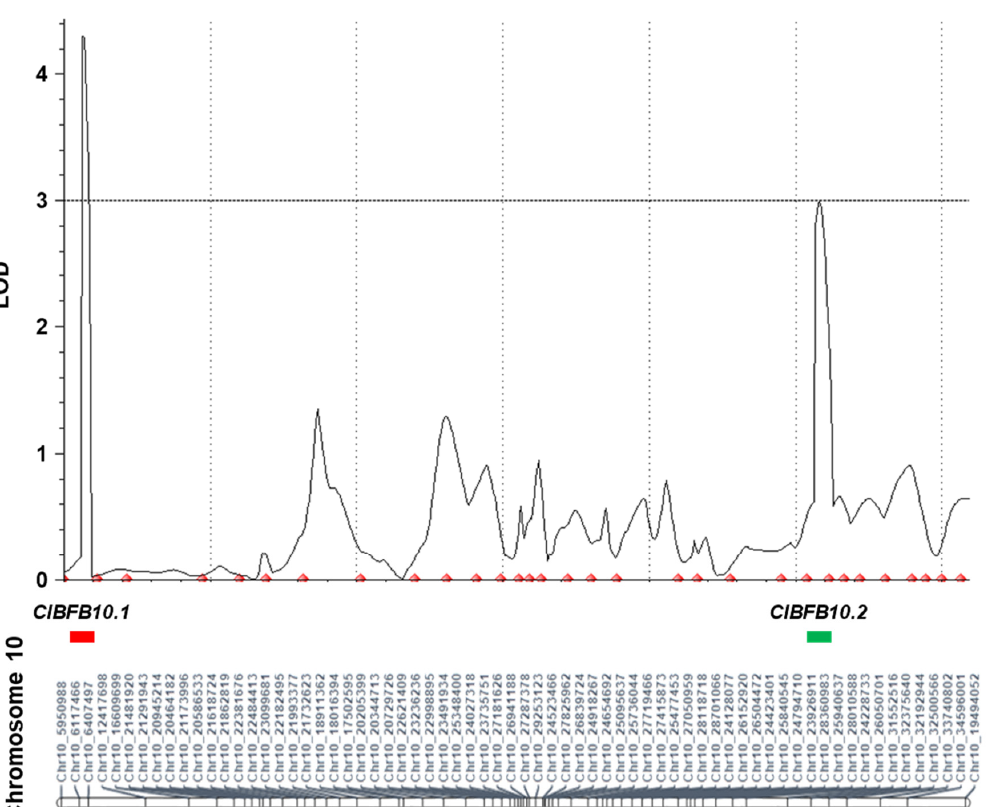
Figure 4. Quantitative trait loci (QTLs) associated with resistance to bacterial fruit blotch (BFB) on chromosome 10 of watermelon. QTLs are identified by composite interval mapping (CIM) analysis. LOD score at peaks are 4.292 and 2.939 for QTLs ClBFB10.1 and ClBFB10.2 , respectively. QTL is